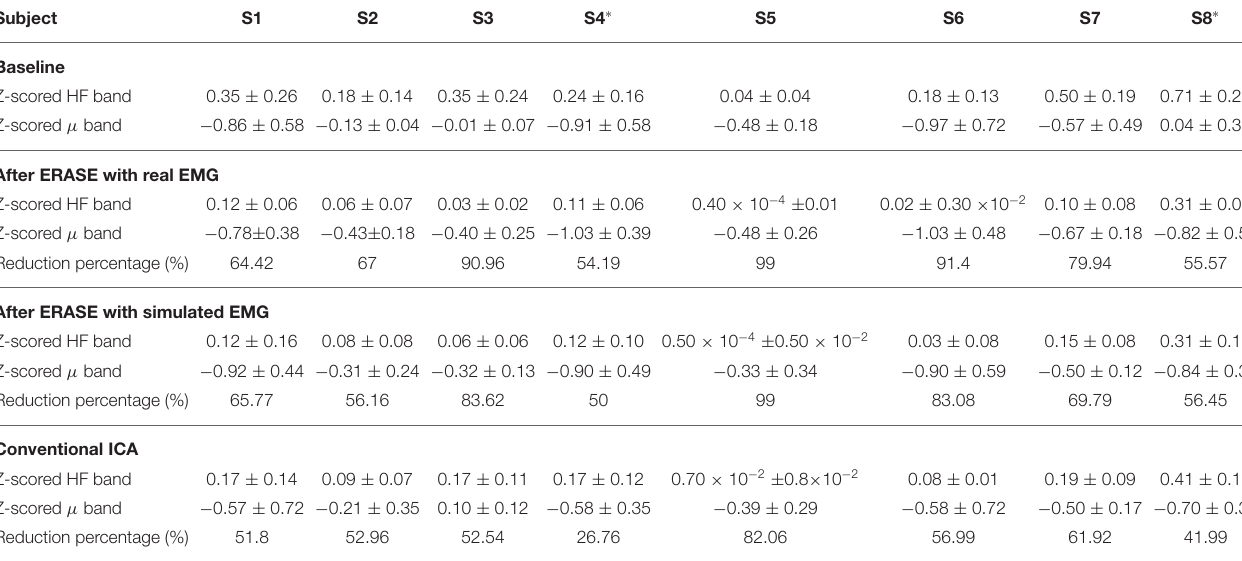
TABLE 1 | Change of HF band power in different conditions for each subject [mean ± standard deviation